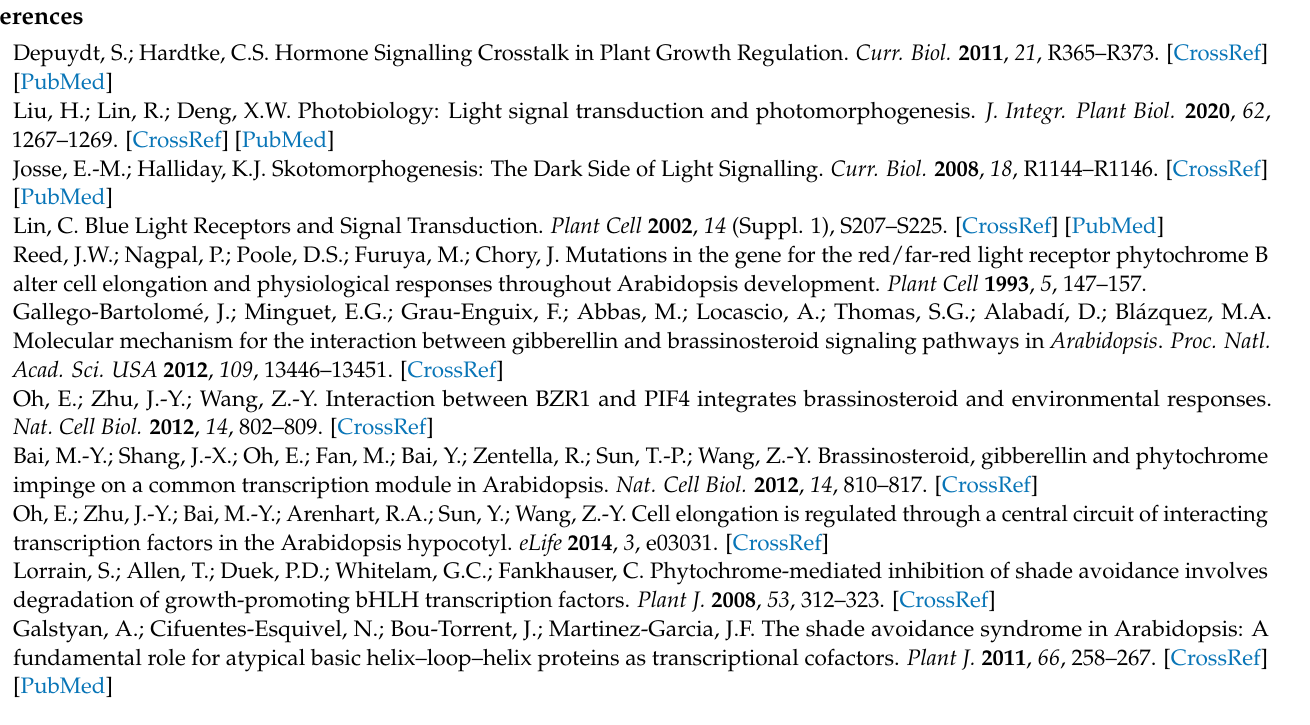
promoter probe; Figure S3: Validation of DEGs identified from RNA-seq by RT-PCR (A) and RT-qPCR (B) analyses; Figure S4: Proteins identified as HLH4 interactors by Y2H library screening; Figure S5: Y2H to show HLH4 interacts with other bHLH proteins; Figure S6: Relative luciferase activities detected in A. thaliana protoplasts co-transformed with the plasmids shown in Figure 6A; Table S1. Differentially expressed genes from RNA-seq; Table S2. HLH4 interacting proteins identified by Y2H screening; Table S3. HLH4OE23-Flag Immunoprecipitation-Mass Spectrometry; Table S4: Primers used in this